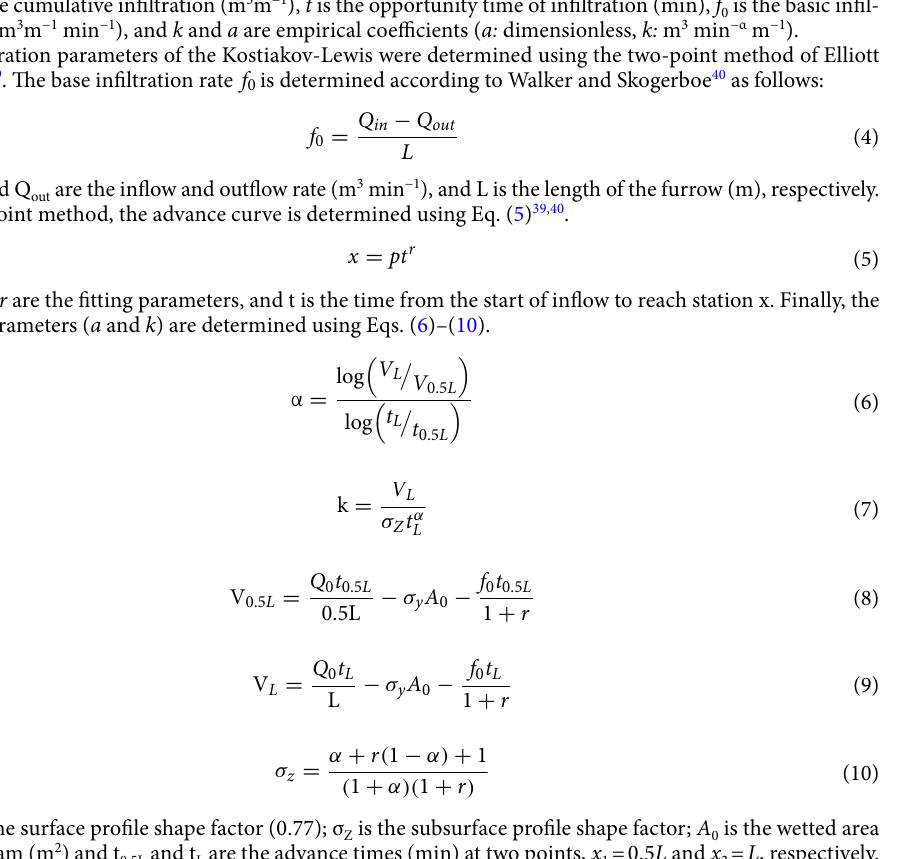
where Z is the cumulative infiltration (m 3 m −1 ), t is the opportunity time of infiltration (min), f 0 is the basic infil- tration rate (m 3 m −1 min −1 ), and k and a are empirical coefficients ( a: dimensionless, k: m 3 min −α m −1 ).